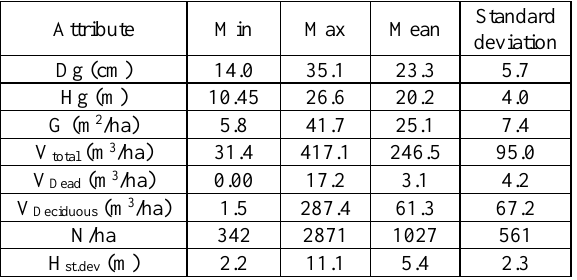
Table 1. Descriptive statistics of forest attributes of the sample plots. Dg = basal-area weighted mean dbh, Hg = basal-area weighted mean height, G = basal area, V = stem volume, and H st.dev = Standard deviation of field measured tree heights on plot